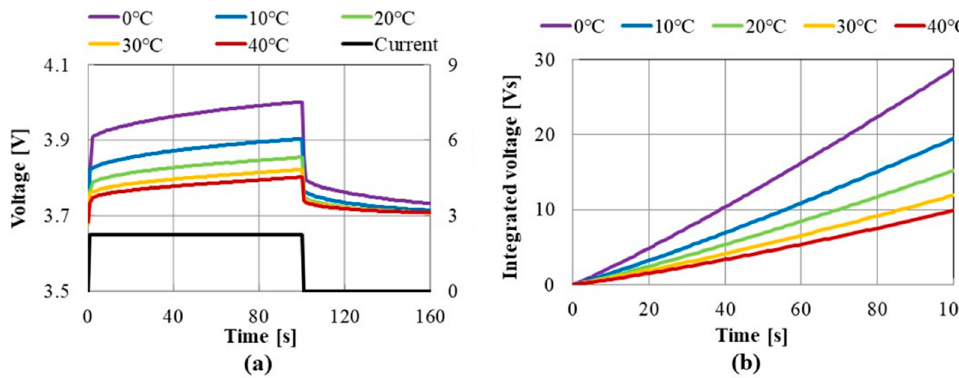
Figure 9. Effect of temperature. ( a ) Voltage. ( b ) Integrated voltage.